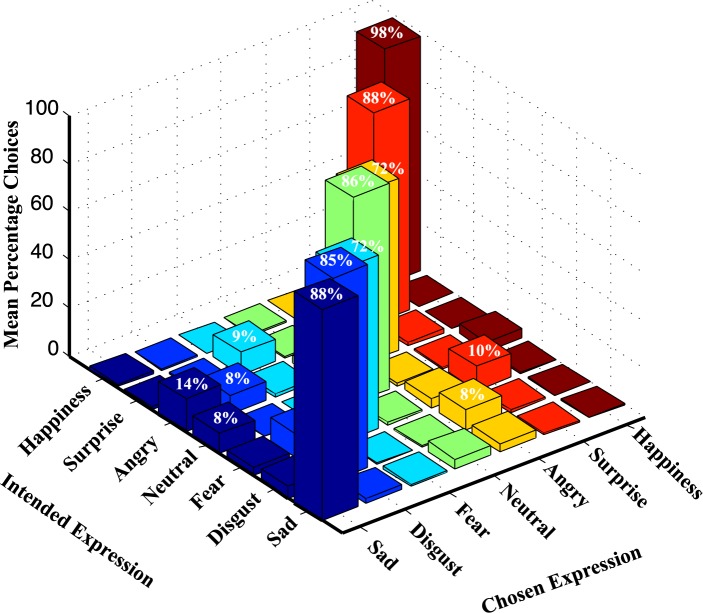
Unbiased hit rates.Three dimensional plot showing mean percentage (y-axis) of the chosen expression (z-axis) by Indian participants as a function of the intended expression (x-axis) of models in the Radboud database.